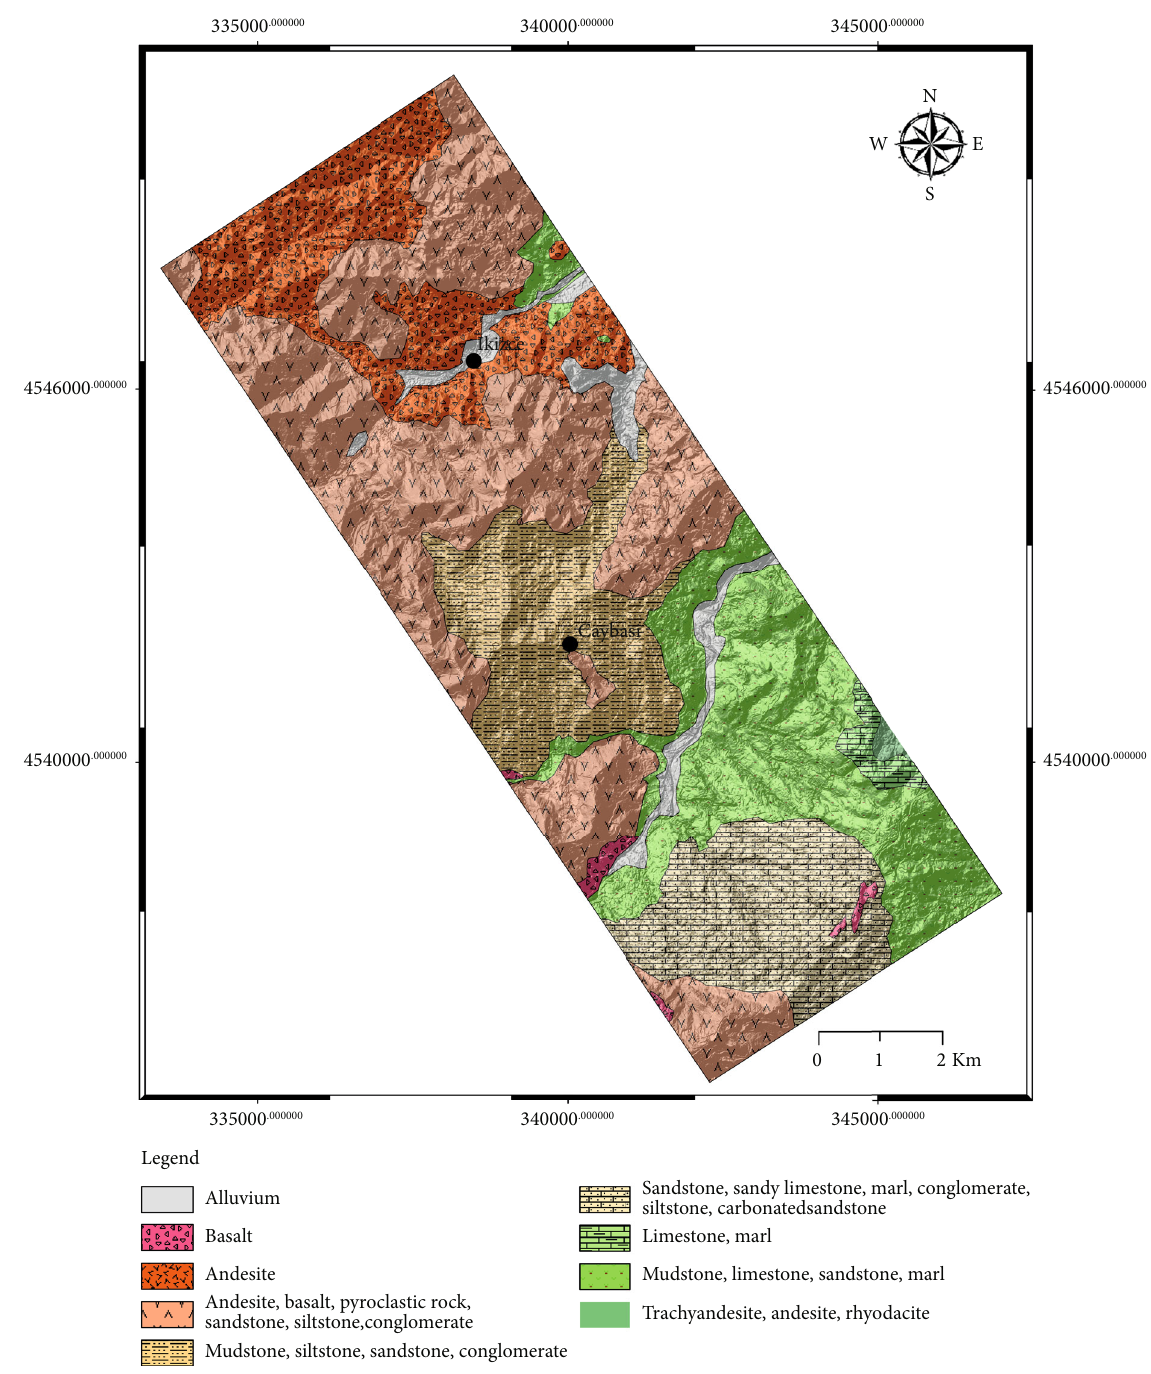
Figure 9: Lithological map of Ikizce-Caybasi area